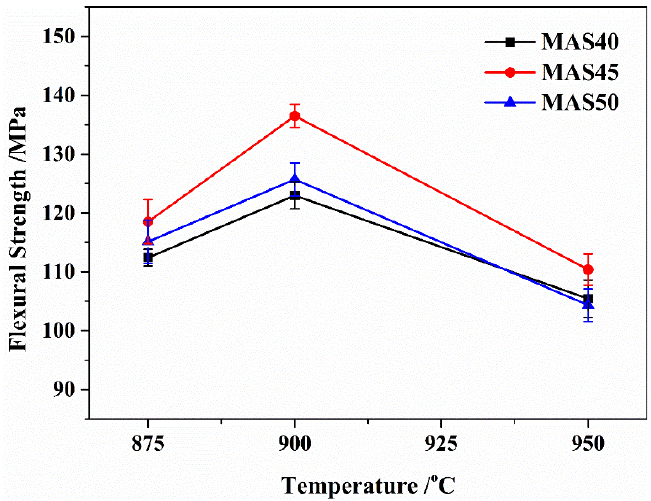
Figure 8. Flexural strength of the glass-ceramics prepared at different sintering temperatures.